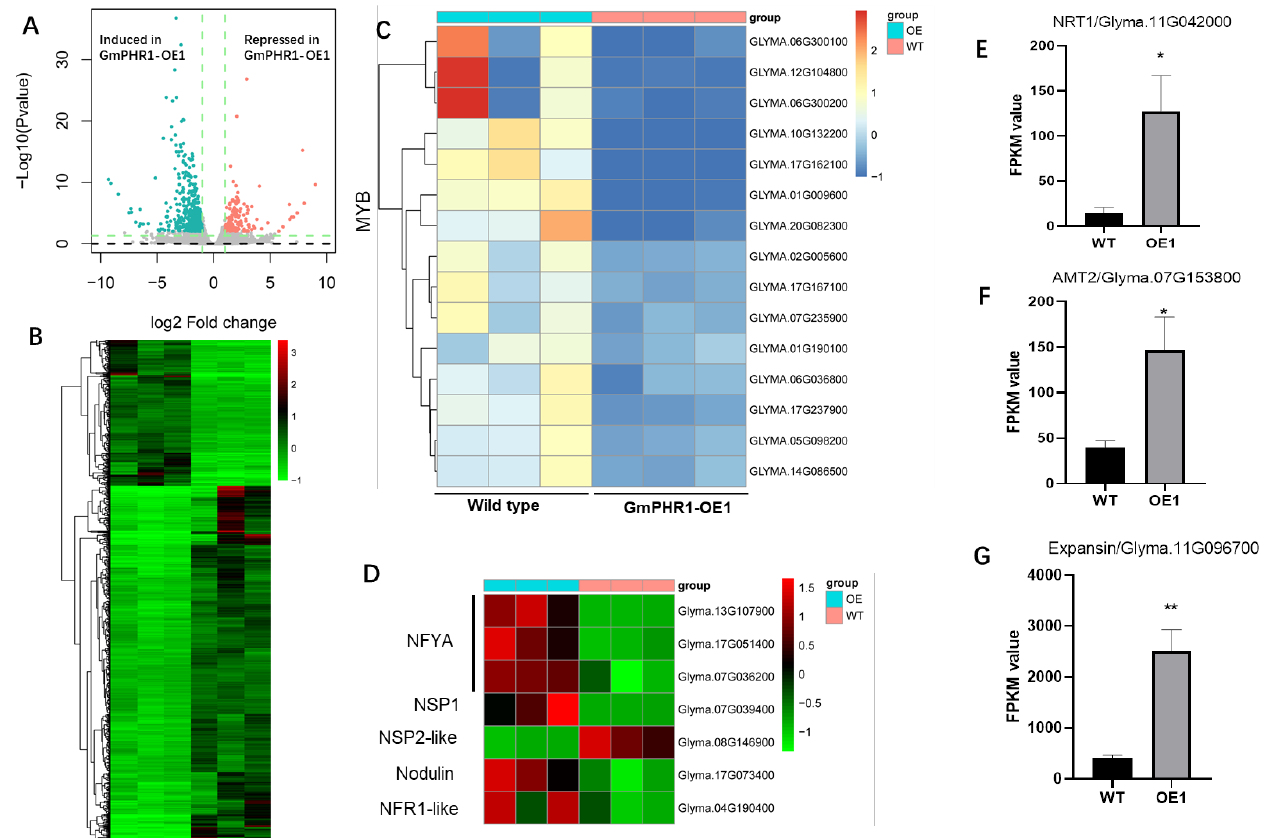
Figure 5. Overexpression of GmPHR1 induces global transcriptional reprogramming in soybeans. ( A , B ). Differentially expressed genes (DEG) compared between wild type and GmPHR1-OE 1 transgenic lines in a volcano plot ( A ) and heatmap ( B ). Significant expression change threshold was a fold change > 2 and an FDR adjusted p value < 0.05. ( C ). MYB transcriptional factors identified among DEGs. ( D ). Significant changes of genes relative to symbiotic signaling genes in soybeans between WT and OE. ( E – G ), Comparison of genes acting in nitrogen acquisition ( E , F ) and growth regulation ( G ) between wild type and GmPHR1-OE 1 transgenic plants. For ( E ) to ( G ), asterisks represent statistically significantly differences from respective controls in the Student’s t test (*: 0.01 < p ≤ 0.05, **: 0.001 < p ≤ 0.01).